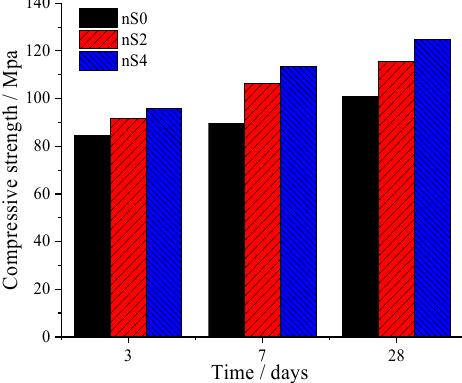
Figure 9. Compressive strength change of UHSCs at 3, 7, and 28 days.